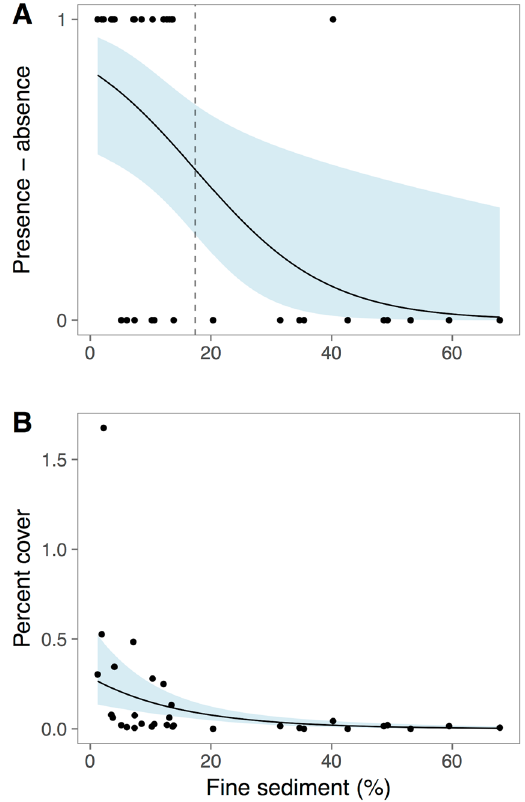
Figure 3. ( A ) Cliona orientalis was more likely to occur at sites with the lowest proportion of fine sediments (z = − 2.5, P = 0.01; Wald test). The line represents the probability of occurrence using a binomial generalized linear model and shading represents the 95% confidence interval. The dashed line indicates the proportion of fine sediments (17%) with a 50% predicted probability of C. orientalis occurrence. Points represent presence- absence and the average fine sediment proportion for each location. ( B ) Cliona orientalis cover significantly decreased as a function of the proportion of fine particles in the sediment (z = − 4.9, p < 0.01; Wald test). The line represents the predicted cover from a negative binomial generalized linear model and shading represents the 95% confidence interval. Points represent average cover and fine sediment proportion for each location.